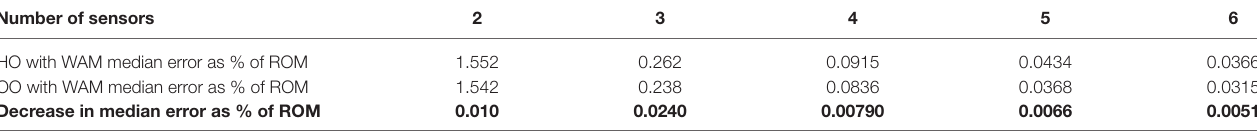
TABLE 4 | Table highlighting the difference in median error as a % of ROM between HO with WAM and OO with WAM. Number of sensors HO with WAM median error as % of